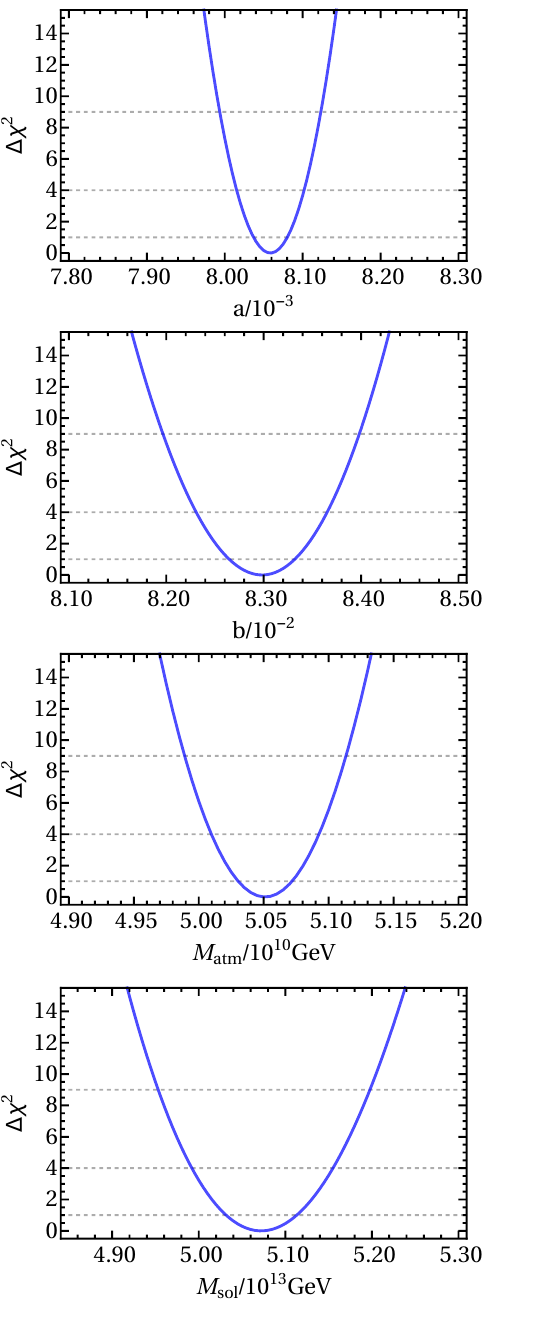
Figure 5 . Perturbations around Case A2 benchmark point shown on the left, those for Case D2 on the right. Each parameter is varied separately as the other three are kept (cid:12)xed. Dashed gray lines show 1, 2 and 3 sigma deviations from the best (cid:12)t in each parameter when varied separately.